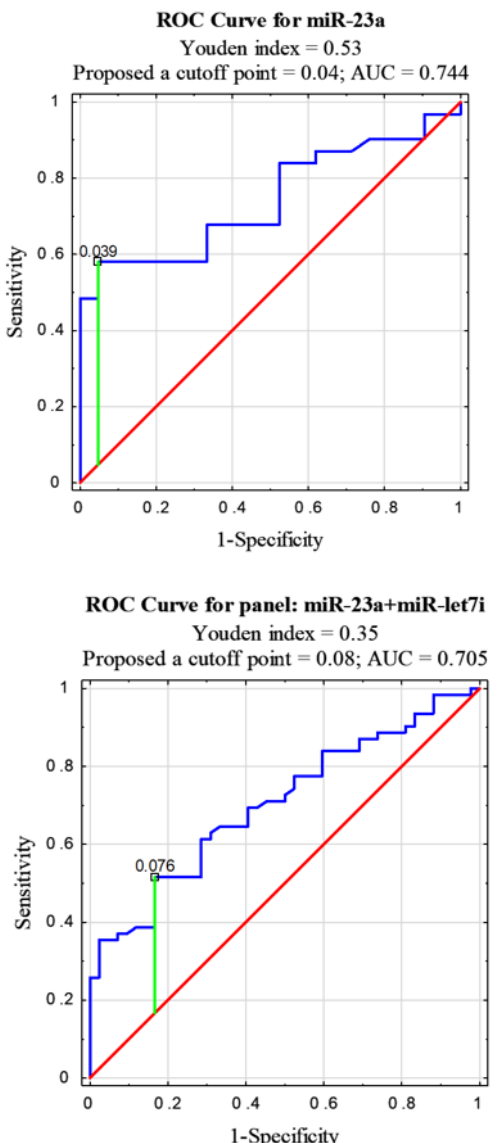
Figure 2. Receiver operating characteristic (ROC) curve analysis for serum EVs miRNA diagnostic potential in differentiating NSCLC and